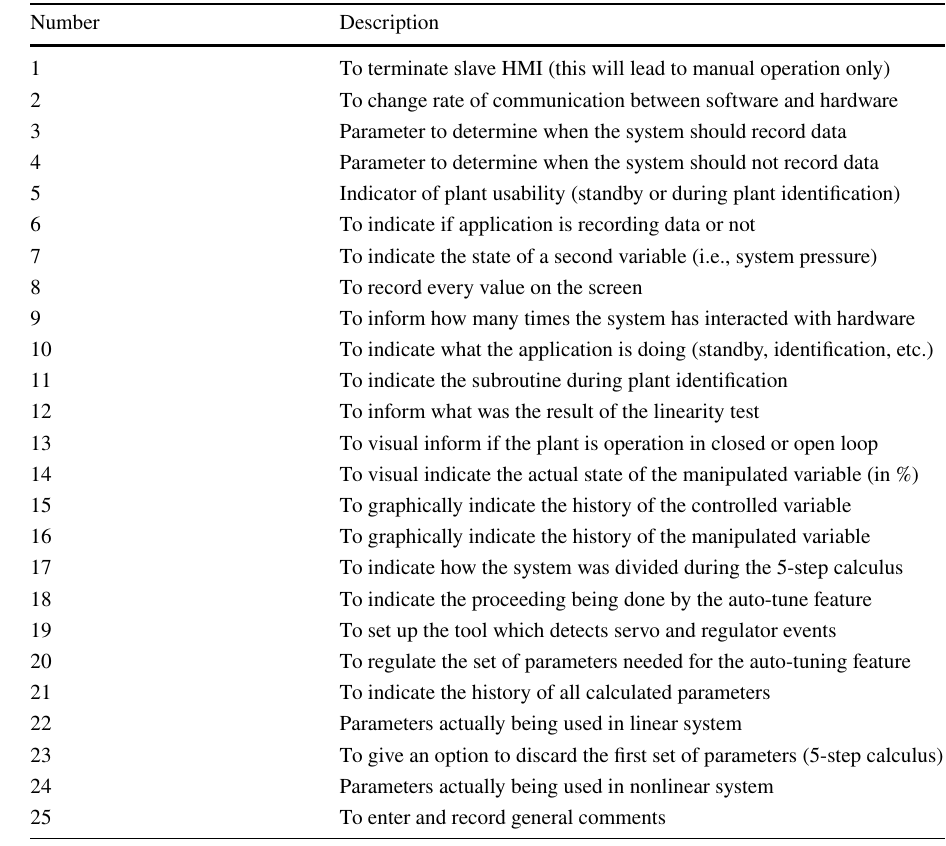
Fig. 6 Flow rate and engine power in function of test